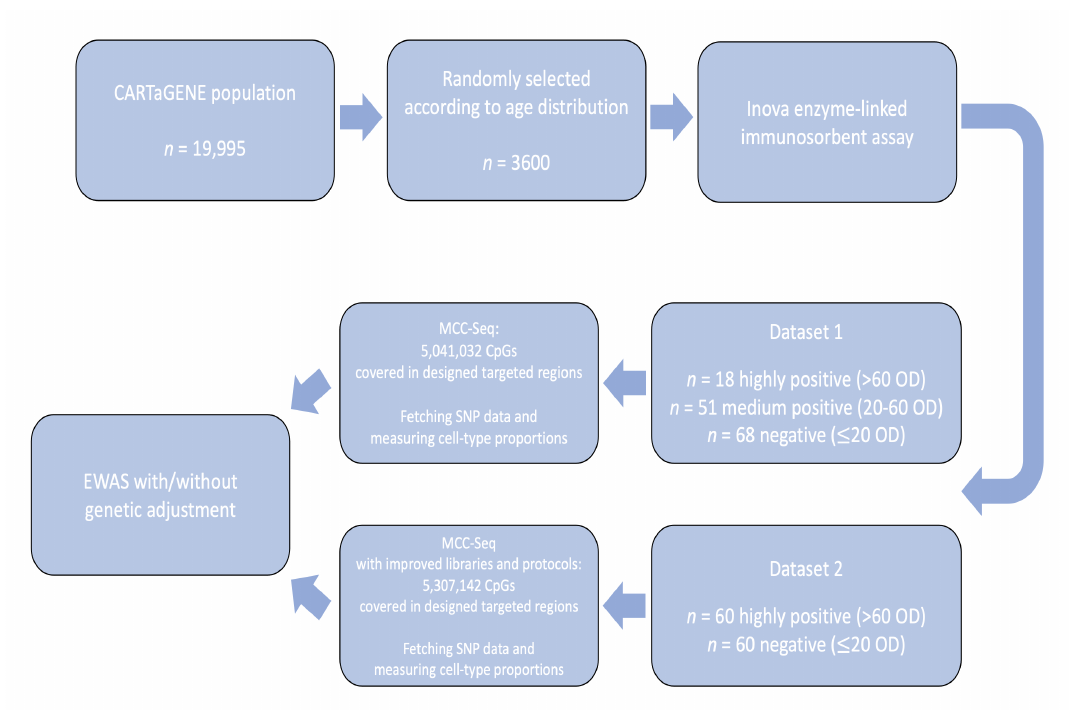
Figure 9. Procedures for data collection and